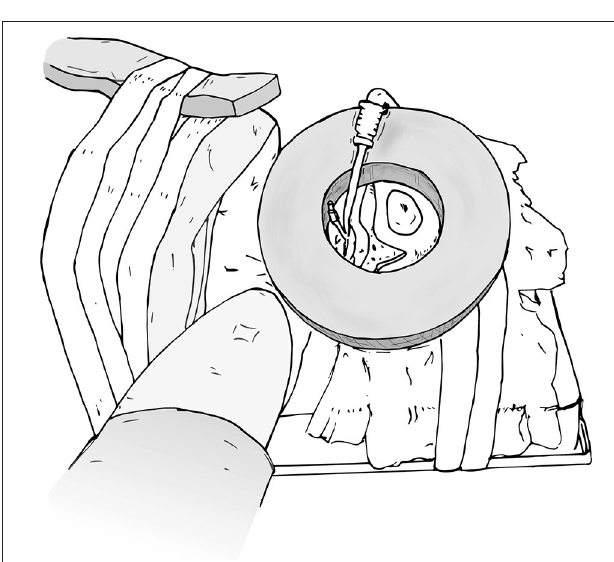
FIGURE 3 | Protect the face with foam to prevent injury or inadvertent manipulation of the endotracheal